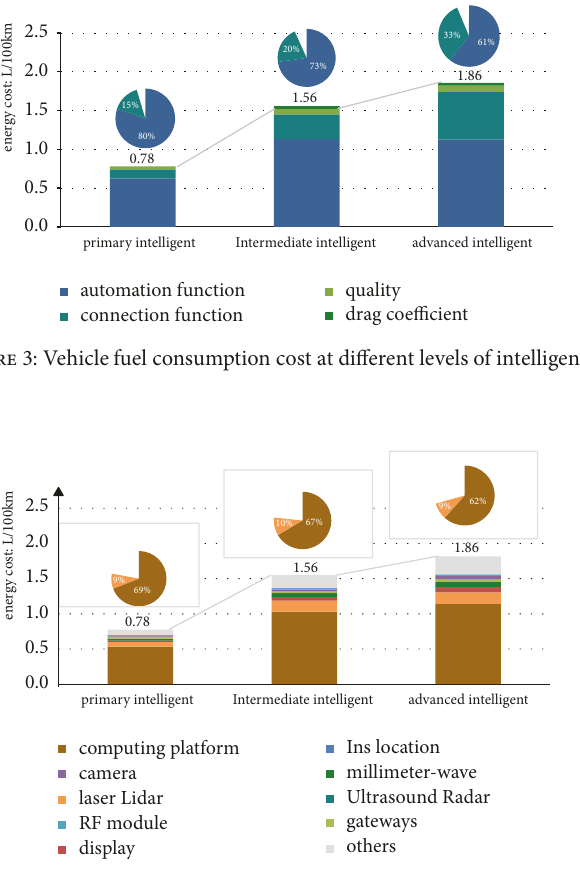
Figure 4: Fuel consumption components of various hardware at different levels of intelligence.